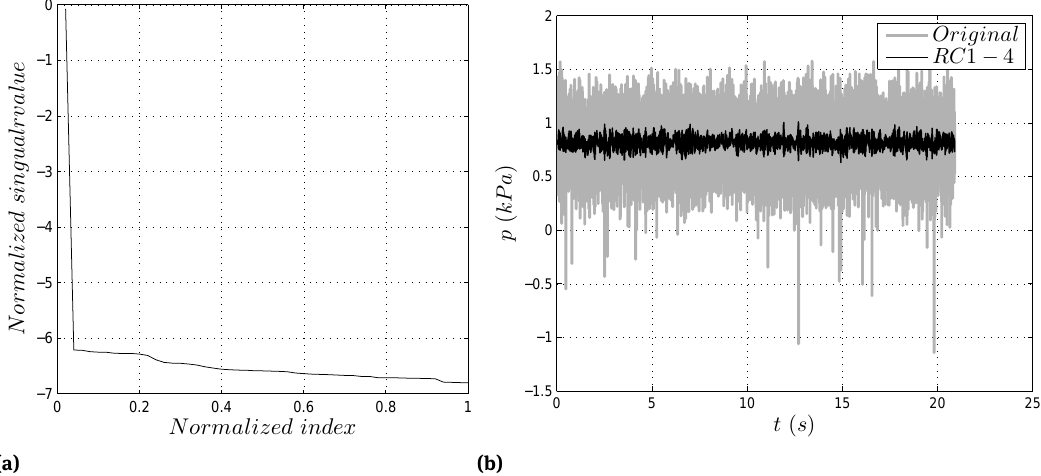
Figure 6: a) Singular value spectra and b) Source signal and sum of its three first principal components at inlet recirculation (TOA = 20%) at the blower inlet